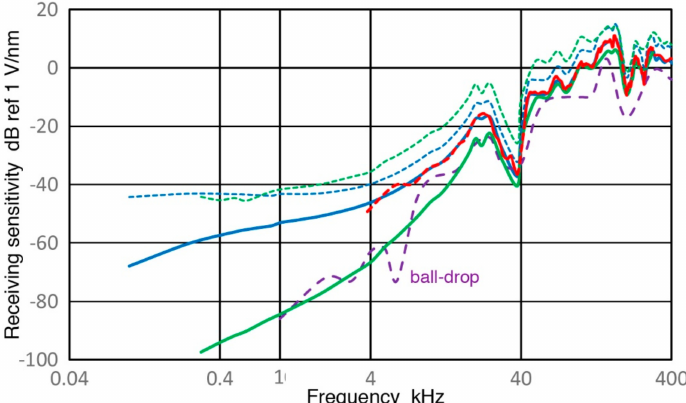
Figure 14. Receiving displacement sensitivity spectra are shown against log-frequency (in kHz) for R15a (0.15) sensor in dB in reference to 1 V/nm using two Z in of 1 M Ω (blue) and 10 k Ω (green). Corresponding pulse sensitivity spectrum is shown in the red dash curve and calculated open-circuit sensitivities are in the blue dot (using data of Z in of 1 M Ω ) and green dot (10 k Ω ) curves. A spectrum obtained by a ball-drop method is plotted for comparison in purple